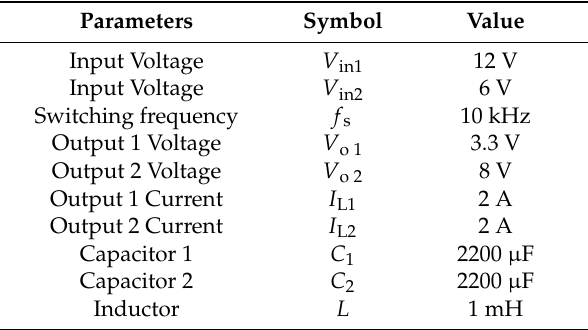
Table 2. Specifications for DIDO